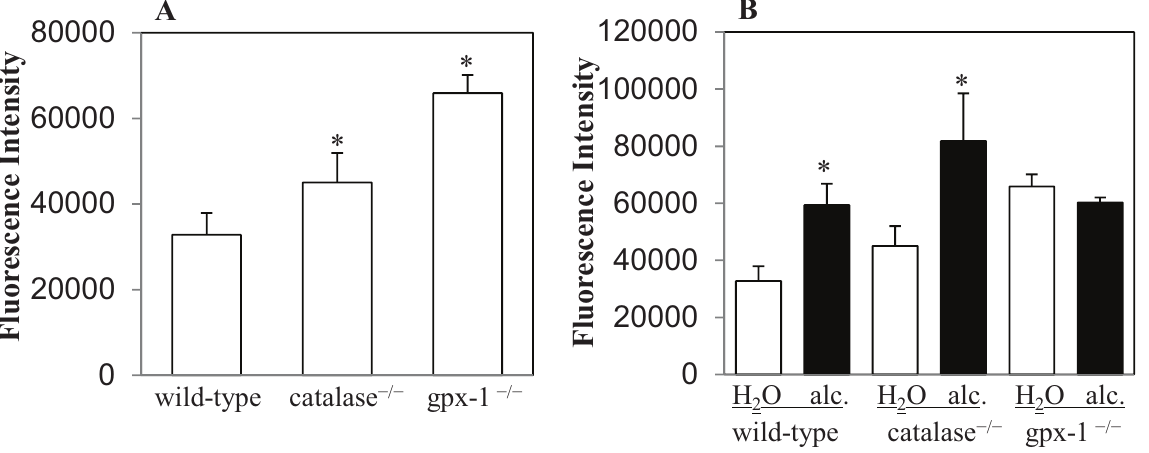
Figure 1. Intracellular H 2 O 2 levels in hepatocytes freshly isolated by perfusion from the livers of untreated wild-type and catalase (cid:2)/(cid:2) or gpx-1 (cid:2)/(cid:2) transgenic mice ( A ), and mice fed with 10% ethanol (alc.) or plain water (H 2 O) for 1 week ( B ) were measured by 2'-7'-dichlorodihydrofluorescein (DCF) fluorescence. DCF fluorescence detected by spectrophotometer in cells incubated with 2'-7'-dichlorodihydrofluorescein diacetate (DCFH-DA) was normalized to that in cells incubated with 0.1% DMSO (control), and expressed as arbitrary fluorescence per 0.5 × 10 6 hepatocytes. Asterisks indicate statistical significance ( p <